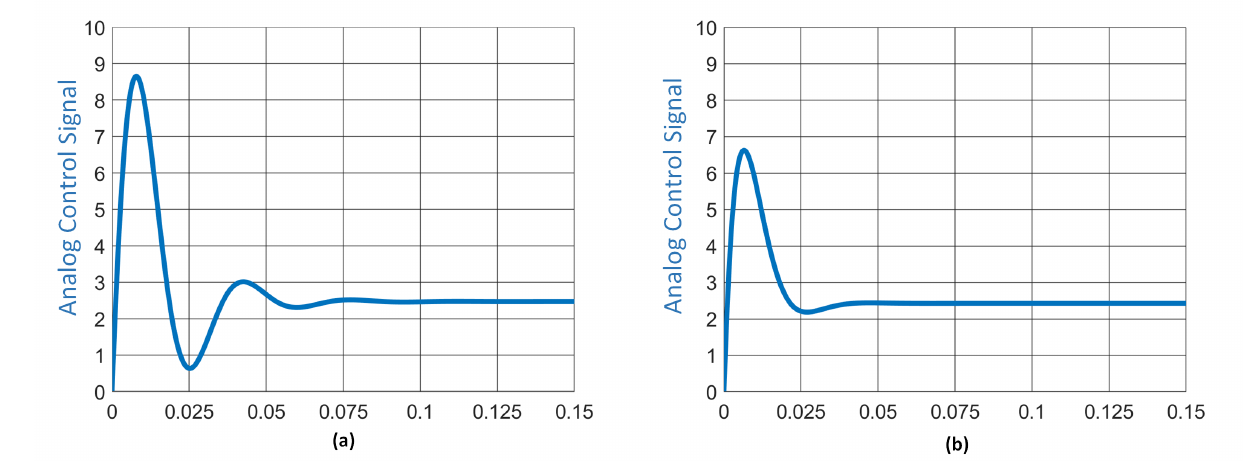
Figure 7. Control effort obtained via simulation. ( a ) PID controller. ( b ) DISMC controller.